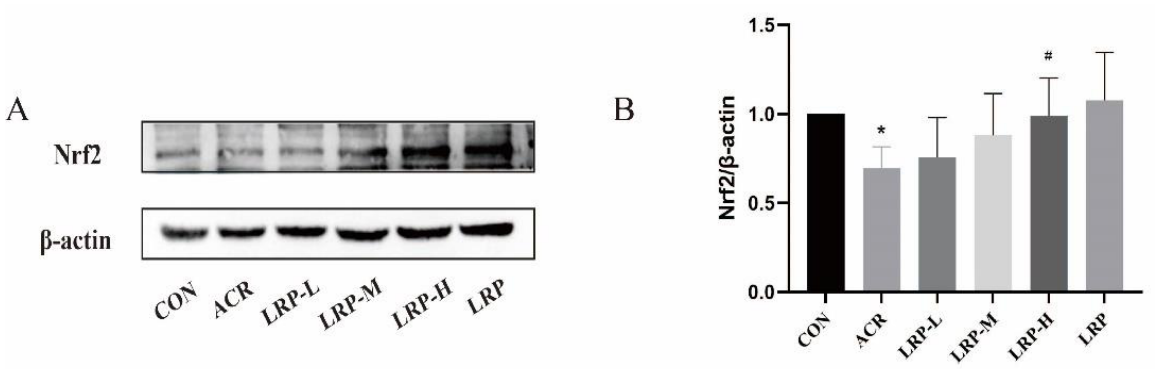
Figure 5. ( A ) Effect of LRP on Nrf2 expression in the liver. The protein expression analysis from the liver of an experimental rat using Nrf2 antibodies. ( B ) The data of the densitometric analysis of Nrf2/ β -actin. Data are expressed as mean ± SD. * p < 0.05 versus the CON group; # p < 0.05 versus the ACR group. ACR, acrylamide; LRP-L, Lycium ruthenicum polyphenols in low dosage; LRP-M,